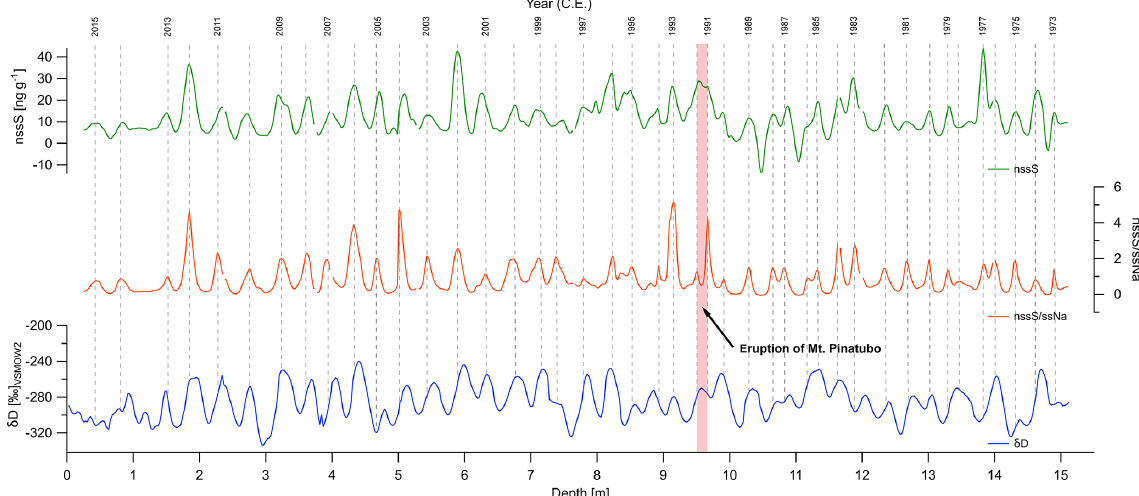
Figure 3. Age scale for firn core PASO-1 constructed by counting and inter-matching of maximum peaks (dashed lines) in profiles of stable water isotope composition ( δ D) as obtained from discrete sample measurements and in CFA-derived profiles of nssS and nssS/ssNa, respectively. The year of the eruption of Mt. Pinatubo (1991) that is used as tie point for annual layer counting is highlighted. Note that the maxima of nssS and nssS/ssNa do not necessarily coincide with the respective maxima in δ D due to the different seasonality of the proxies.